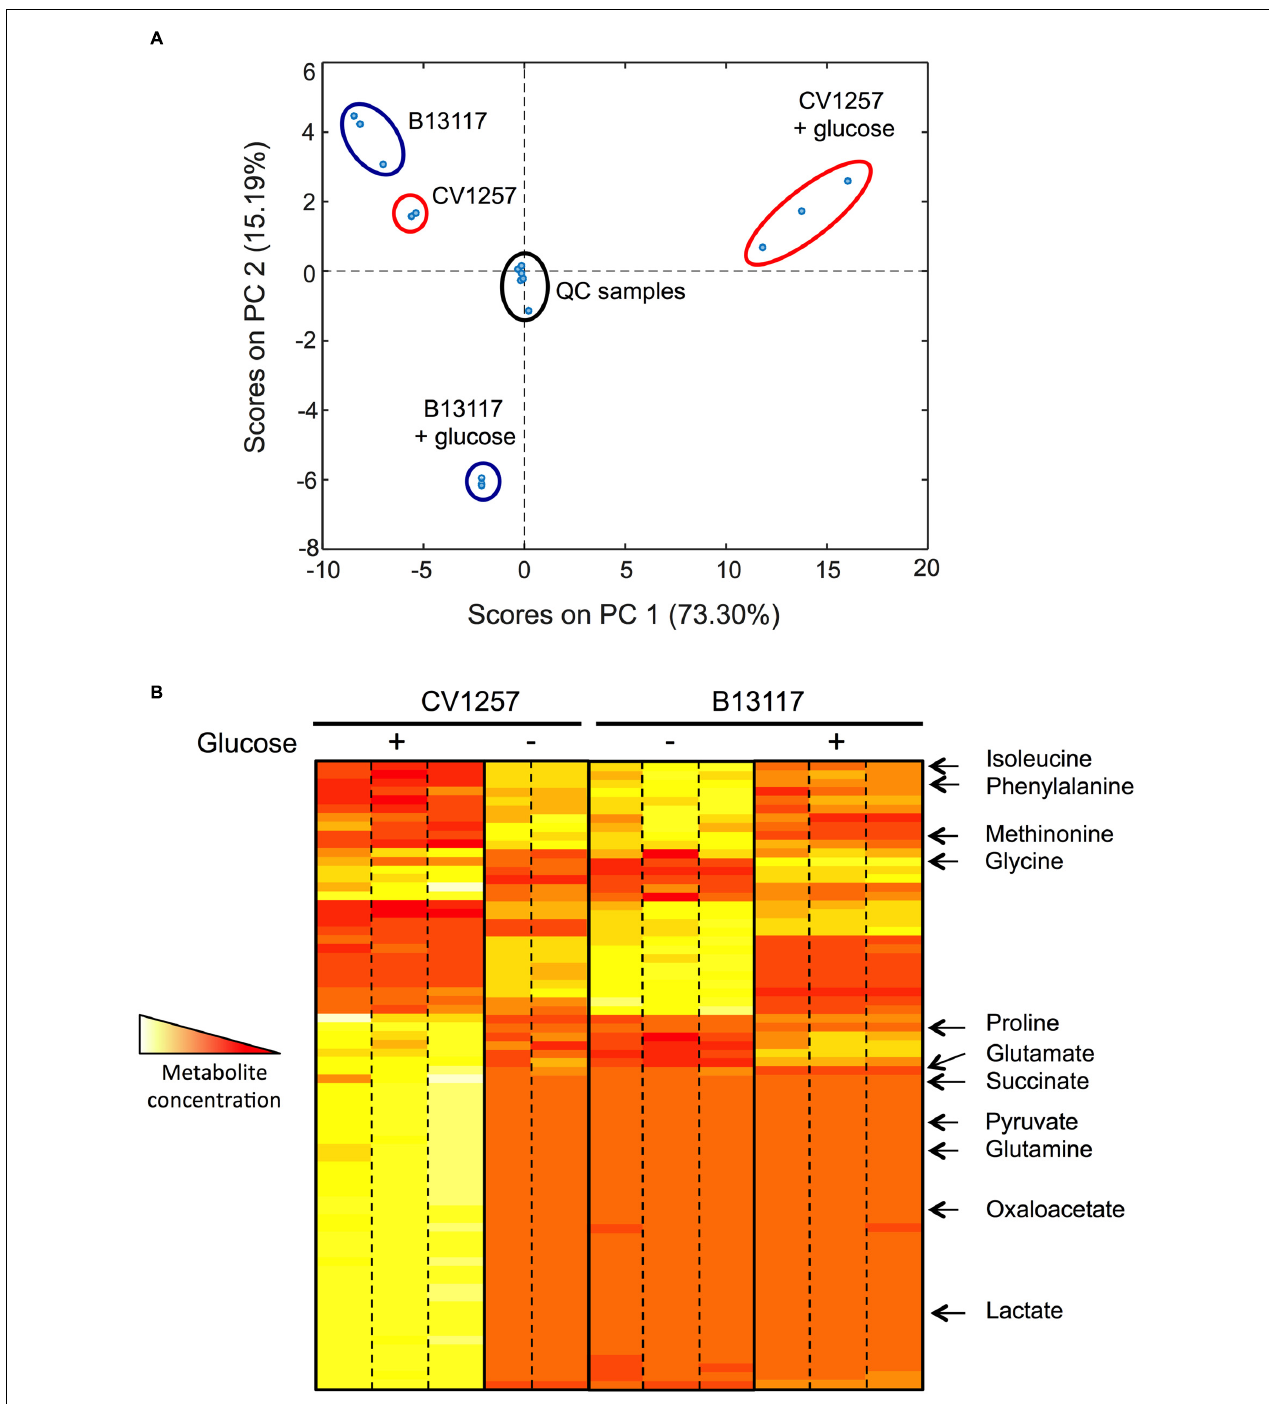
FIGURE 7 | Glucose dependent changes in extracellular metabolic profiles of B13117 and CV1257 isolates. (A) Principal components analysis (PCA) plots of extracellular metabolites determined by gas chromatography–mass spectrometry (GC–MS). The PCA score plot is based on a data set consisting of three independent replicates of C. coli B13117 and CV1257 cultivated in TSB with and without glucose for 24 h at 37 ◦ C in a microaerobic atmosphere. However, only two replicates of CV1257 without glucose were used due to contamination. For quality control, mixed pooled samples (labeled QC samples) were run alongside the individual separate samples. (B) Heat map representation of the most abundant extracellular metabolites of C. coli B13117 and CV1257 samples used in (A) . When cultivated without glucose the two isolates display very similar metabolite profiles (two middle panels). Upon glucose supplementation both isolates display a distinct shift in metabolic profile (two outer panels), but the two isolates respond very differently to glucose metabolism, which is seen by the highly different overall profile patterns with glucose. Compounds that could be identified by comparison to standards are shown; most compounds that could be detected were not identified. The colors represent the relative concentrations from high (white) to low